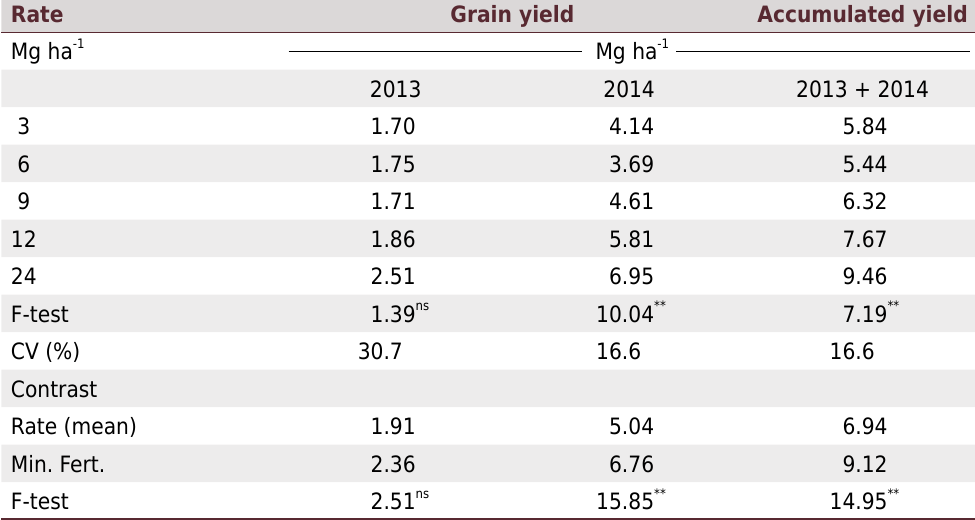
Table 6. Corn grain yield and accumulative yield, for the 2013 and 2014 crops, and analysis of variance